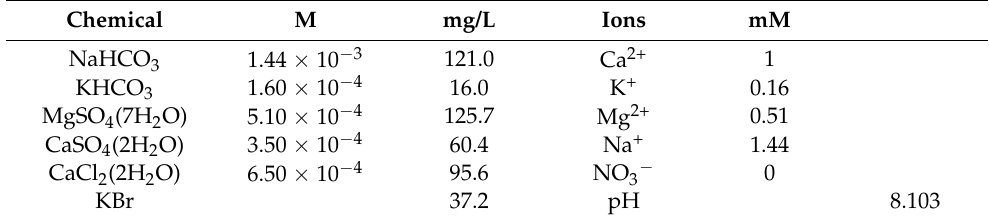
Table 1. Synthetic